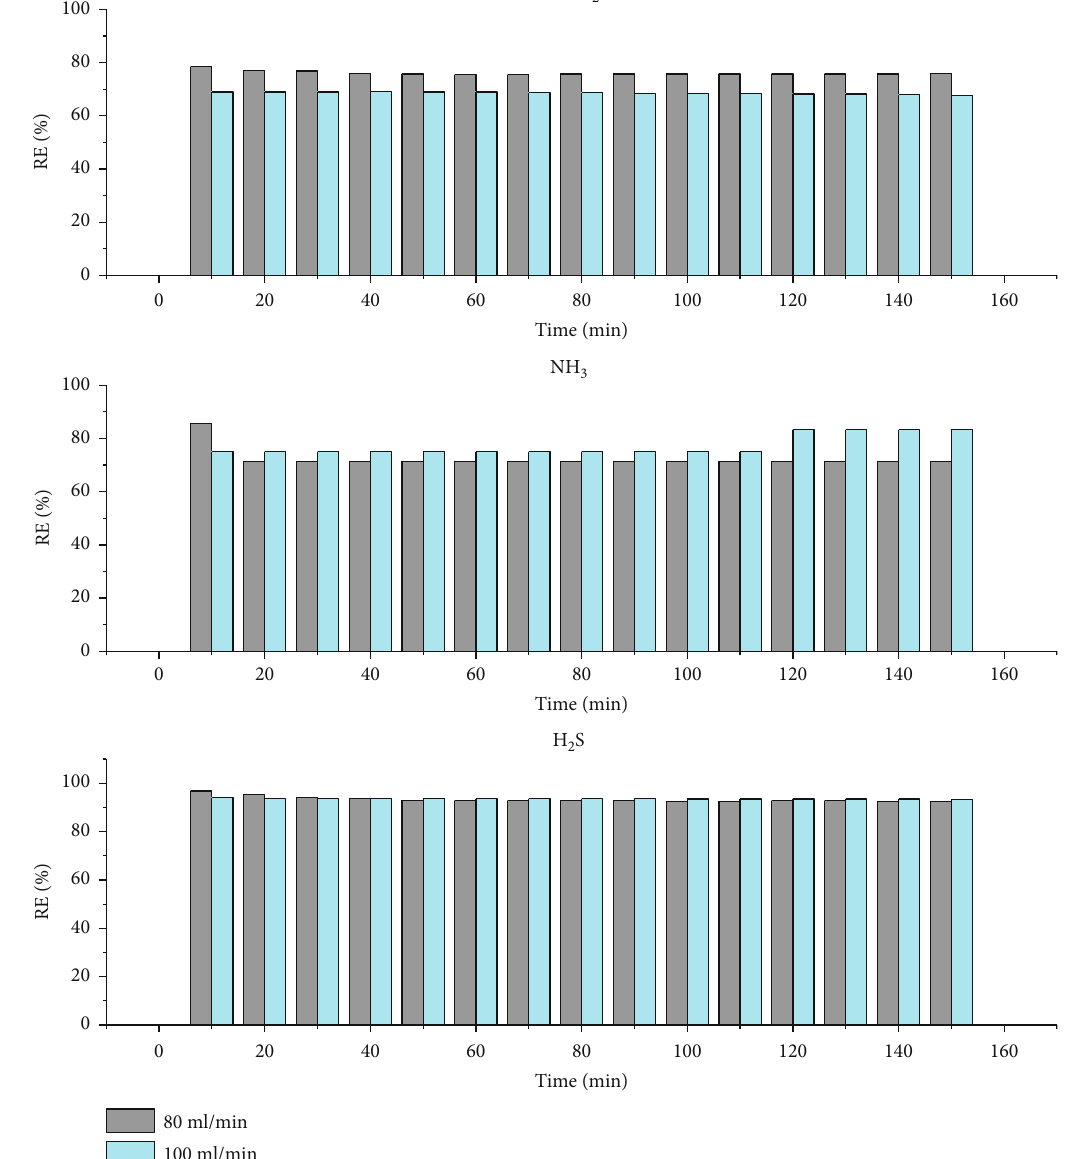
= 80 ml/min, Q = 100 ml/min m=100g, 1 2